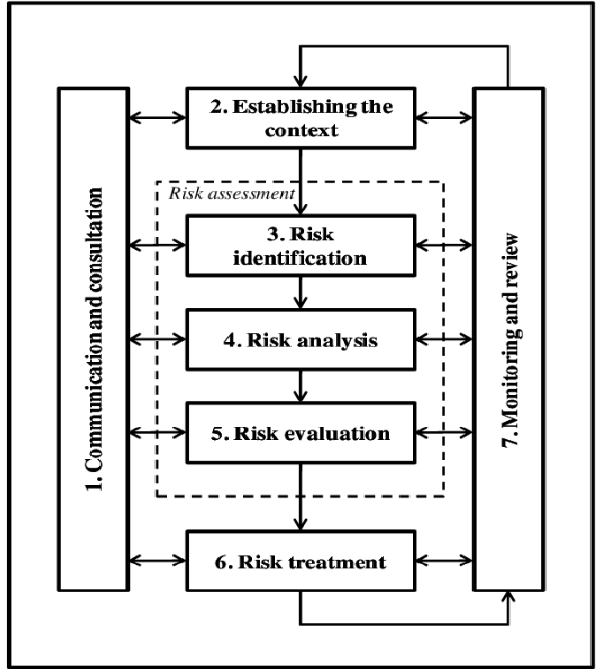
Figure 1. Process of the risk management. Source: ISO (2009, 2018); Oehmen et al. (2010); Bugdol and Jedynak (2012).